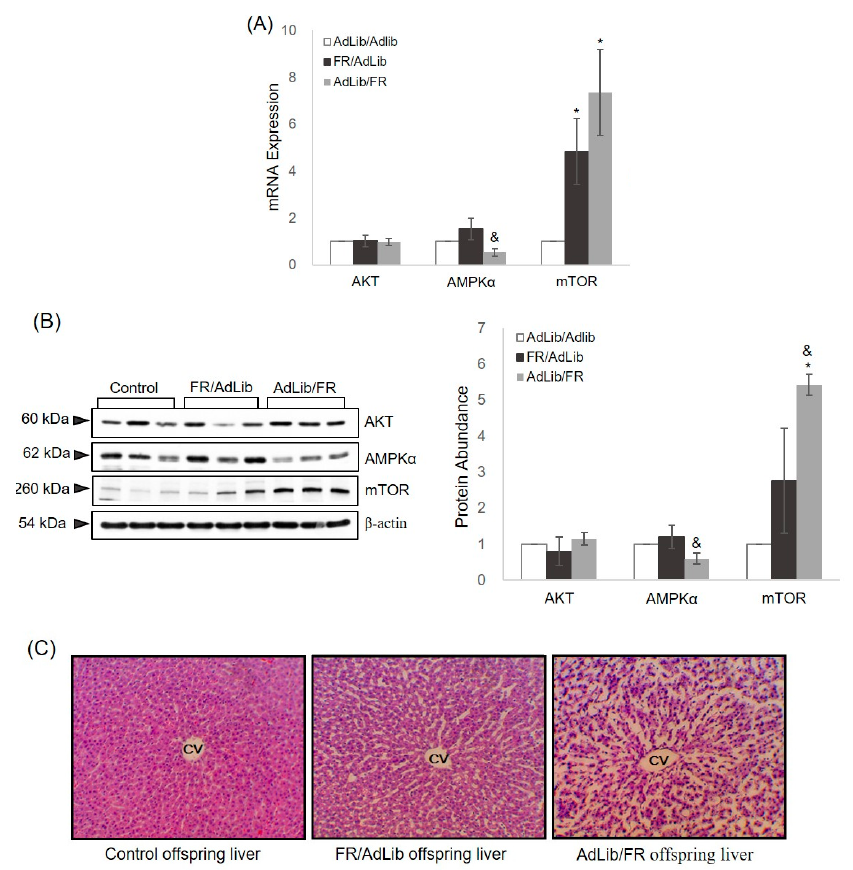
Figure 2. Relative mRNA and protein levels of the hepatic growth-related gene in three-week-old male offspring. ( A ) The liver levels of mRNA encoding AKT, AMPK α , and mTOR were determined by real-time PCR in the three groups ( n = 9 control, n = 9 FR/AdLib, and n = 9 AdLib/FR). Each value was calculated using the ∆∆ C t method (the cycle threshold value method) and was normalized to that of GAPDH. Data are presented as means ± SDs; ( B ) the protein expression levels of AKT, AMPK α , and mTOR were measured by Western blotting in the three groups ( n = 9 control, n = 9 FR/AdLib, and n = 9 AdLib/FR). β -actin served as the reference protein for normalization of band intensity. Data are presented as means ± SDs. p -values indicate the significance of the differences among the groups (one-way ANOVA). * ( p < 0.05) vs. control, and & ( p < 0.05) vs. FR/AdLib or AdLib/FR; ( C ) a photomicrograph of offspring livers in the three groups. Liver tissues from male offspring stained with hematoxylin and eosin (H & E) showing dilated and congested central veins. Original magnification, 200 × . mTOR, mammalian target of rapamycin; AMPK α ,